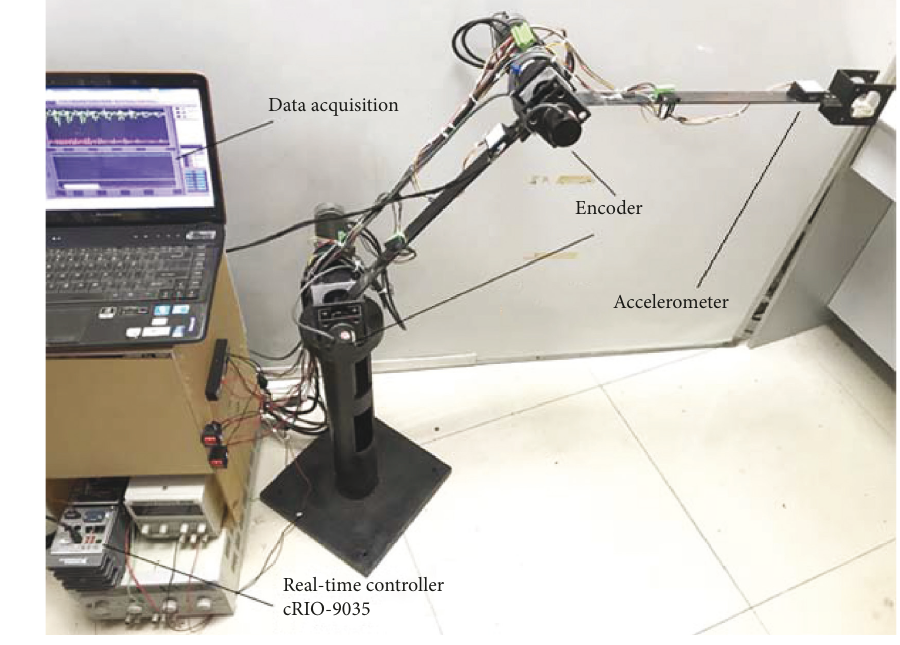
Figure 6: Physical model of 2-DOF flexible manipulators.